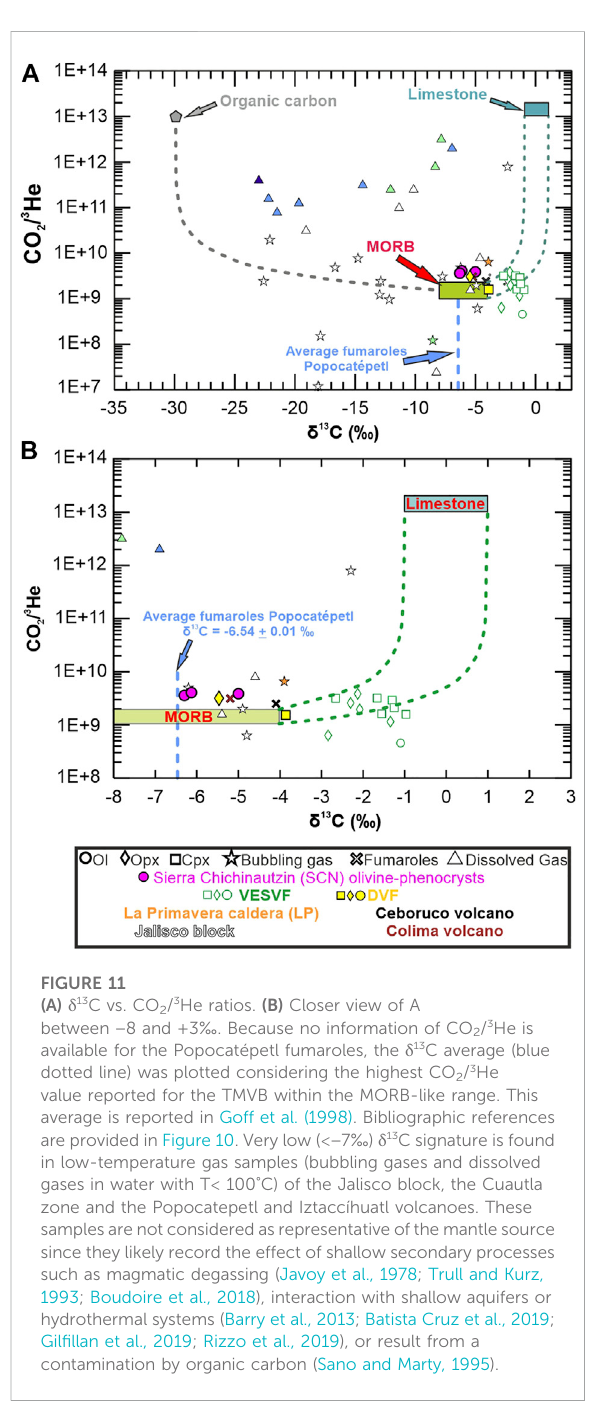
FIGURE 11 (A) δ 13 C vs. CO 2 / 3 He ratios. (B) Closer view of A between − 8 and +3 ‰ . Because no information of CO 2 / 3 He is available for the Popocatépetl fumaroles, the δ 13 C average (blue dotted line) was plotted considering the highest CO 2 / 3 He value reported for the TMVB within the MORB-like range. This average is reported in Goff et al. (1998). Bibliographic references are provided in Figure 10. Very low ( < − 7 ‰ ) δ 13 C signature is found in low-temperature gas samples (bubbling gases and dissolved gases in water with T < 100 ° C) of the Jalisco block, the Cuautla zone and the Popocatepetl and Iztaccíhuatl volcanoes. These samplesarenotconsideredasrepresentativeofthemantlesource since they likely record the effect of shallow secondary processes such as magmatic degassing (Javoy et al., 1978; Trull and Kurz, 1993; Boudoire et al., 2018), interaction with shallow aquifers or hydrothermal systems (Barry et al., 2013; Batista Cruz et al.,